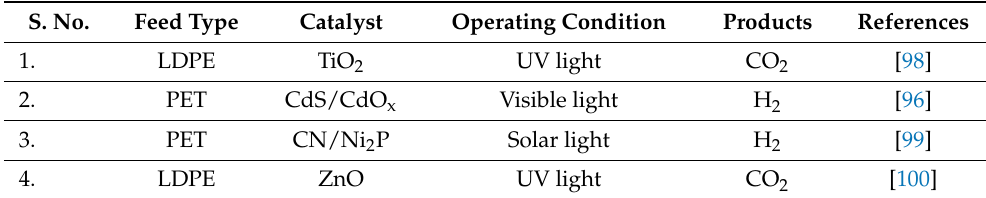
Table 7. Photocatalytic conversion of plastic waste to fuel. S.